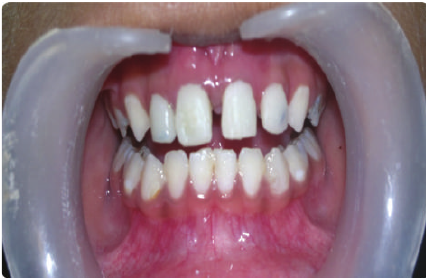
Figure 11: Postoperative clinical photograph after 6